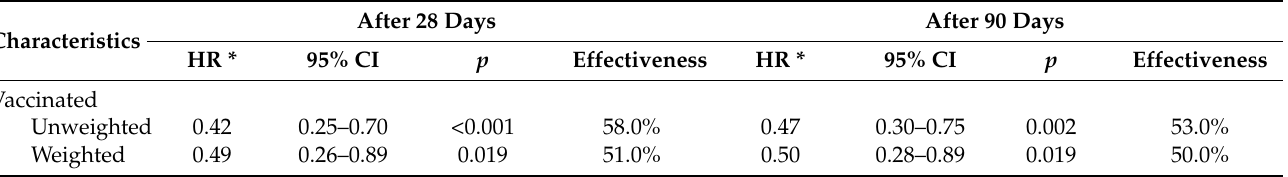
Table 4 for more information. Additional information on propensity score weighting can be found in Supplementary Material Figure S1. Table 4. COVID-19 vaccine effectiveness against death and weighted hazard ratios for